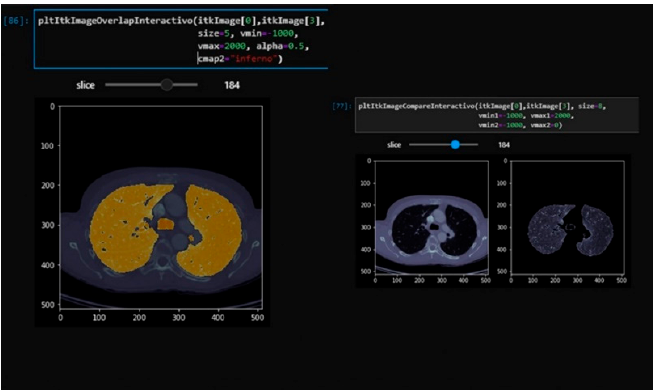
Figure 3. Real-time interactive viewer for the complete tomography using the original image ( left ) and a binary mask ( right ) with our Jupyter Lab’s visualization module.